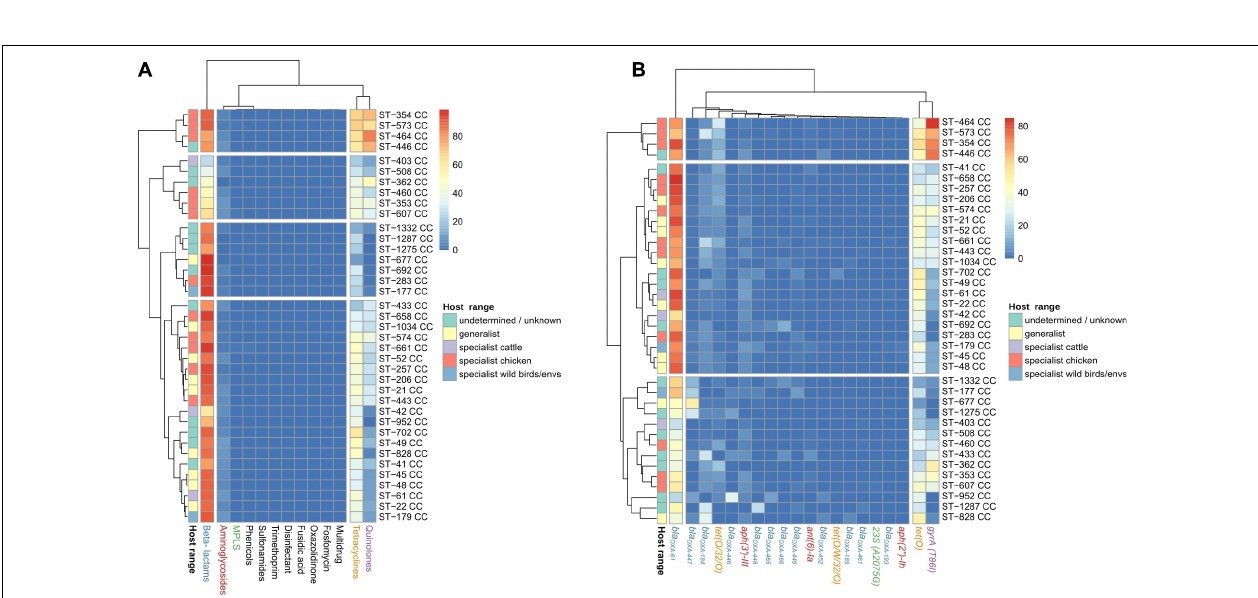
FIGURE 6 | AR genes and SNP distribution among C. jejuni CCs. Heatmap plot showing the percentage of genomes per CC carrying (A) ARGs or SNPs associated with resistance to antibiotic families and (B) particular ARGs or SNPs, showed in columns. Only the main 20 ARGs or SNPs are presented, because the clustering by isolation source remained the same as when the 120 AR determinants were used (data not shown). The Host_range classification of CCs is according to previous publications (see Table 1 ), except for those with highlighted edges, where edge color indicates previous classification while fill color indicates the new assignment, according to the results showed in Figure 4 . Gene names are colored according to the corresponding antimicrobial family (blue: beta-lactams, orange: tetracyclines, red: aminoglycosides, purple: quinolones, and green: MLSP).